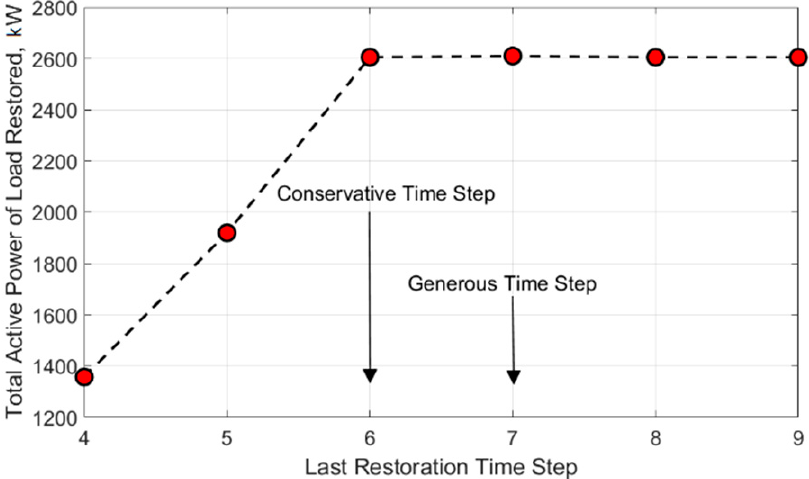
Figure 8. Total Active Power of Load Restored using Different Restoration Steps Parameter.